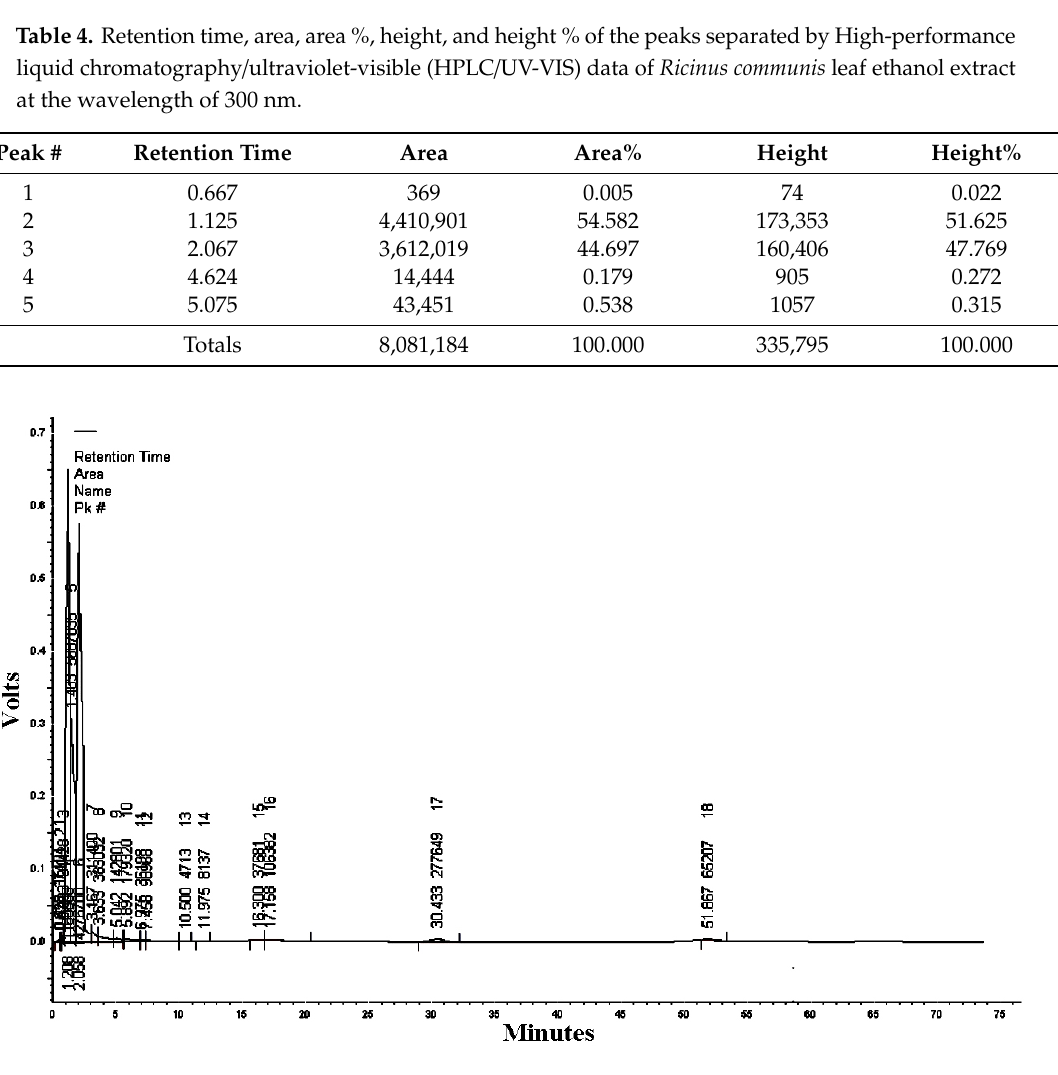
Figure 7. High-performance liquid chromatography/ultraviolet-visible (HPLC/UV-VIS) chromatogram of Ricinus communis leaf ethanol extract monitored at the wavelength of 220 nm.